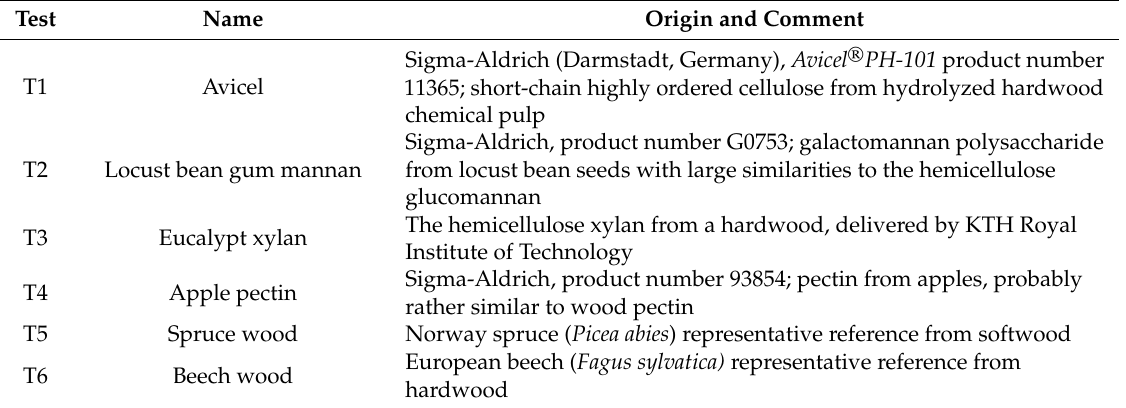
Table 1. All test materials with name and their